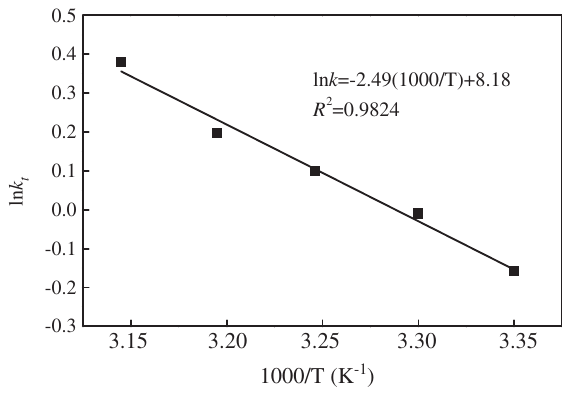
Figure 7: The variation in -ln(1- α ) with time for different temperatures.